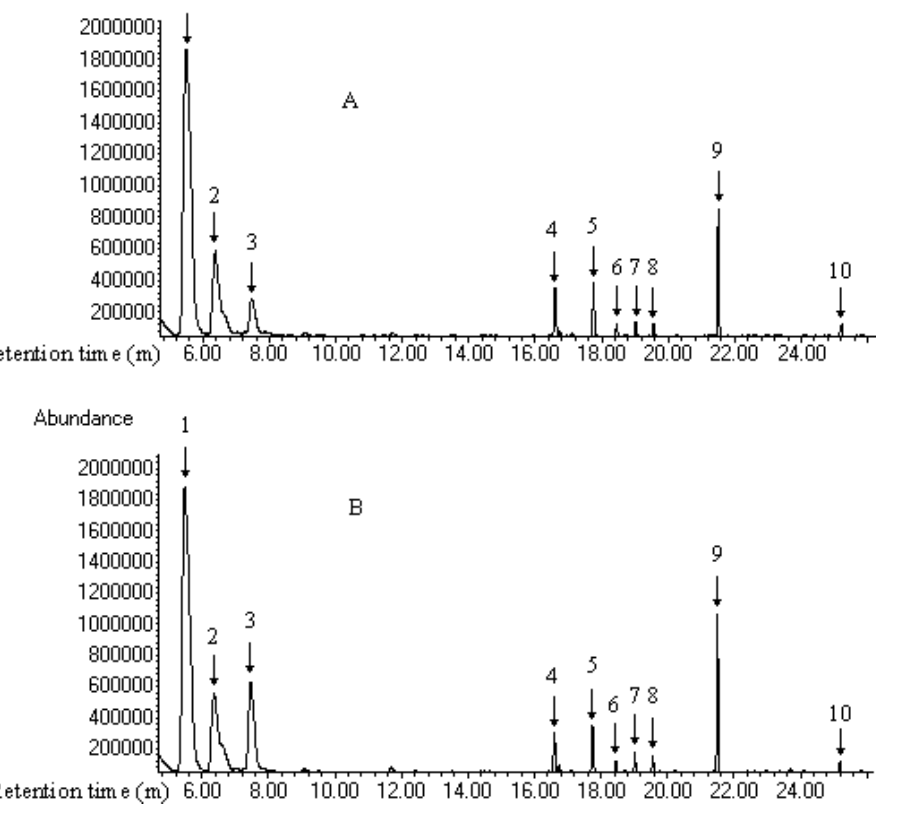
Figure 2. Typical gas chromatograms of male (A) and female (B)H.parallelushindgut extracts. Each extract contains contents from 20 individuals. 1 a -pinene, 2 b -pinene, 3 limonene, 4 norinone, 5 myrtenal, 6 trans -verbenol, 7 cryptone, 8 cis -verbenol, 9 myrtenol, 10 isoborneol.